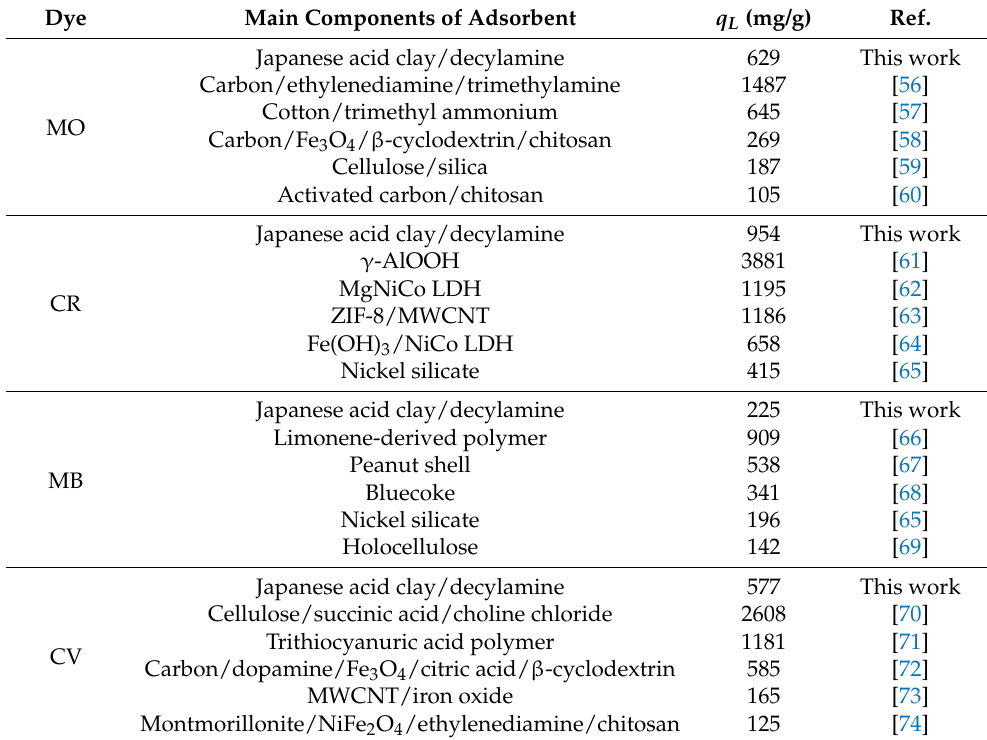
Table 6. Comparison of Langmuir adsorption capacities of the DA5 sample with literature values.